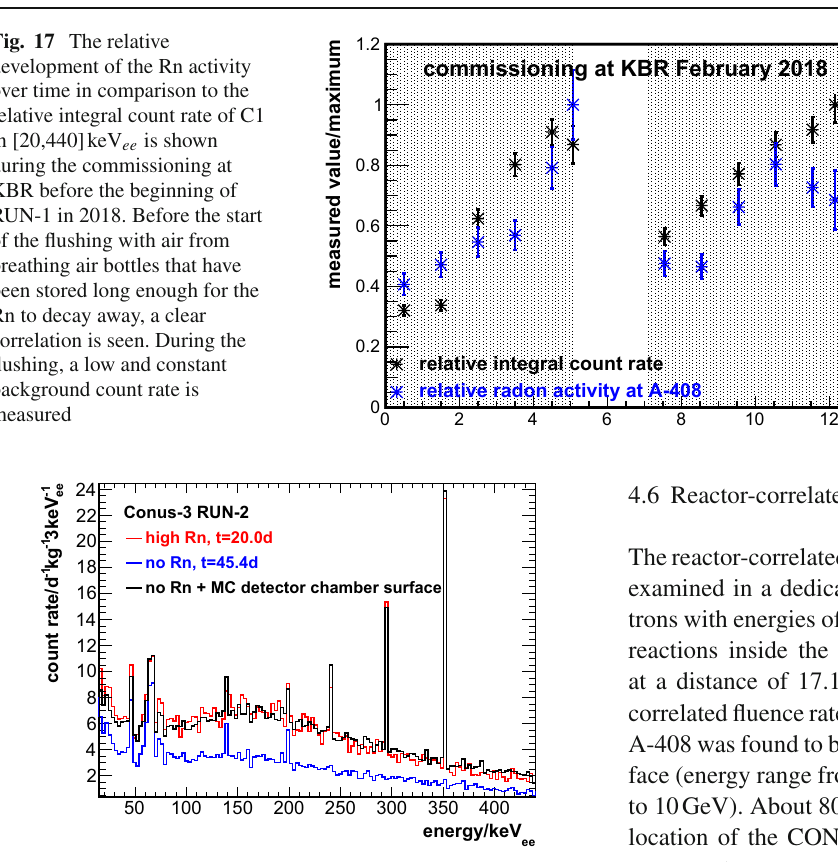
Fig. 18 Simulation of Rn contribution to the background spectrum of C3: the MC simulation of the decay of the relevant Rn daughters on the surfaces within the detector chamber is added to a Rn-free background spectrum. The MC is scaled so as to reproduce the data collected during times where a strong Rn background was present within the detector chamber. In this way, the contribution of Rn decays to the ROI can be